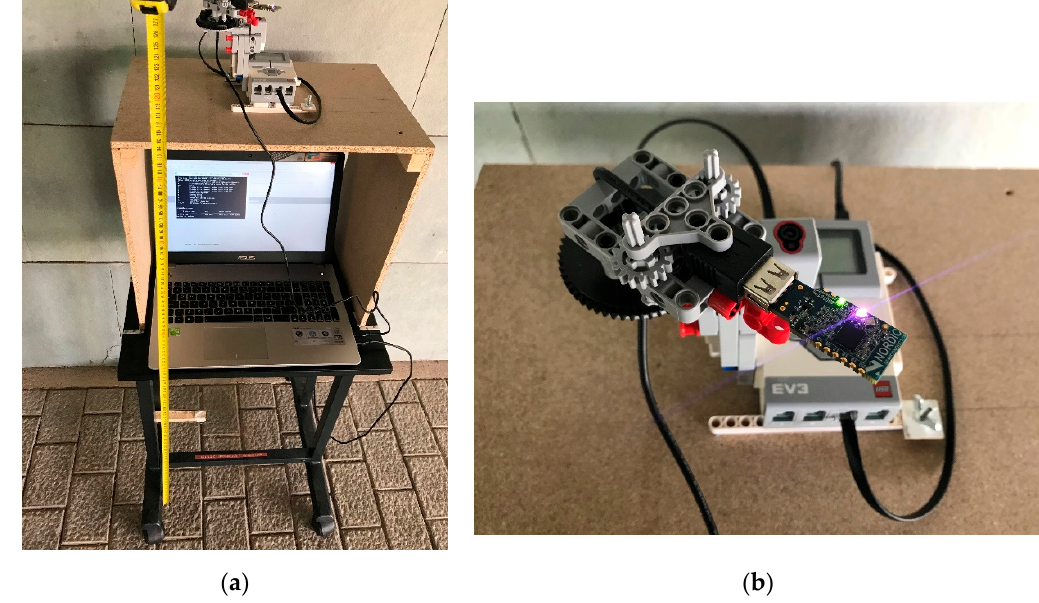
Figure 2. The orienting device: ( a ) General view mounted on the table showing connections to the laptop and its height to the ground; ( b ) Close view with the BLE dongle and the USB cable that connects it to the